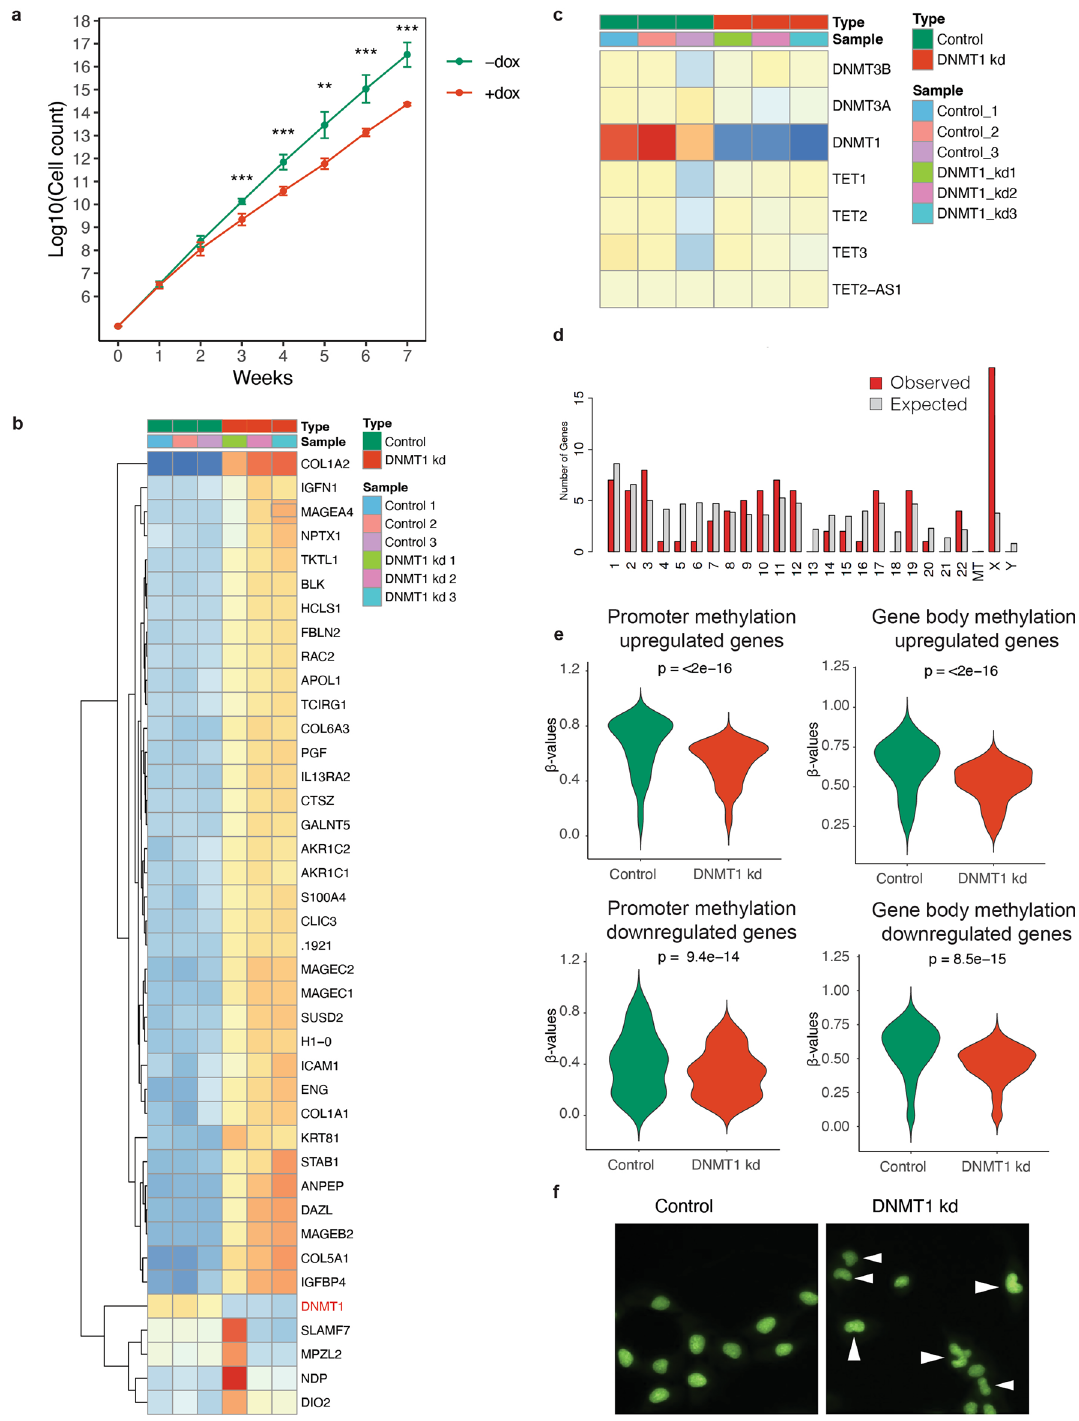
Figure 2. Phenotype of DNMT1 knockdown cells ( a ) Growth curves of doxycycline induced DNMT1 knockdown cells and control cells (n = 4 per condition per time-point). ( b ) Unsupervised hierarchical clustering heatmap of the 40 most differentially expressed genes between doxycycline induced DNMT1 knockdown cells and control cells. ( c ) heatmap of the expression of the writers (DNMT genes) and erasers (TET enzymes) of DNA methylation in doxycycline induced DNMT1 knockdown cells and control cells. ( d ) Distribution of genes on chromosomes as determined by ShinyGO 0.76 81 . Chi-square test p = 5.8E-08. ( e ) Violin plots of the β-values for genes, promoters and CGIs for the differentially expressed genes (p adj < 0.05). Statistical test: paired Wilcoxon signed-rank test.( f ) Morphology of control cells and cells with hypomethylated genomes. Arrowheads denote cells with abnormal nuclear